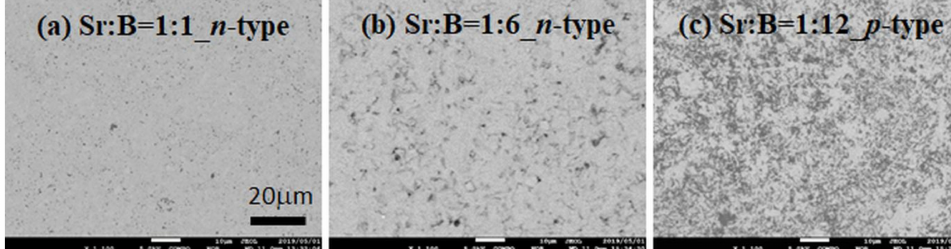
Figure 3. Back-scattering electron images of sintered SrB6 bulk specimens. The image of the p -type specimen is apparently inhomogeneous. Dark contrast regions could be Sr-deficient regions. ( a ) Sr:B = 1:1_ n -type; ( b ) Sr:B = 1:6_ n -type;.( c ) Sr:B = 1:12_ p